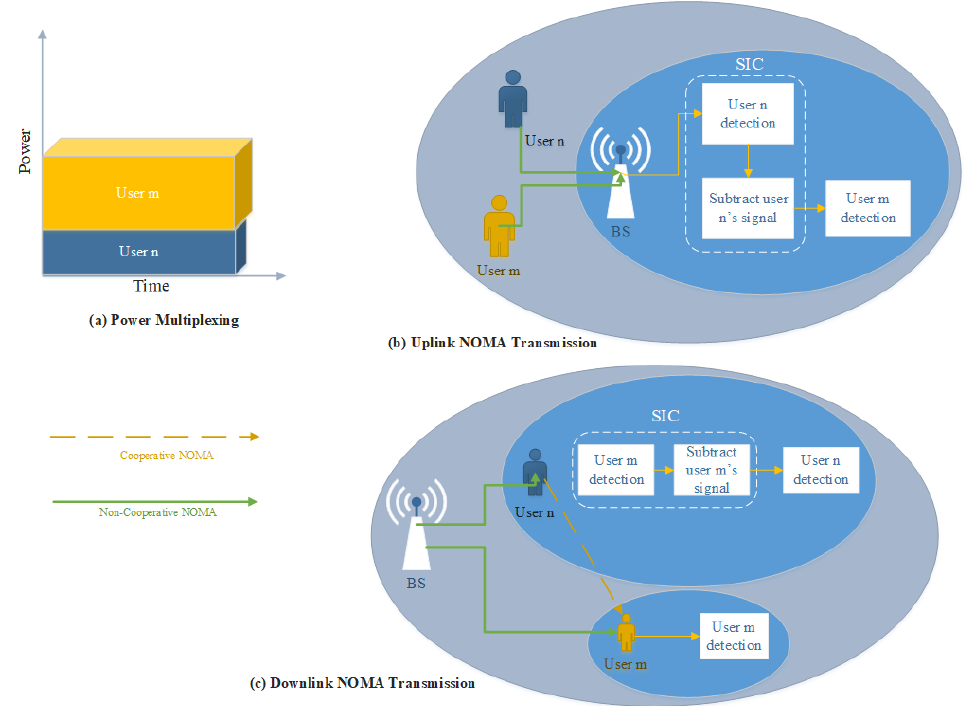
Figure 6. Principle of transceiver of NOMA